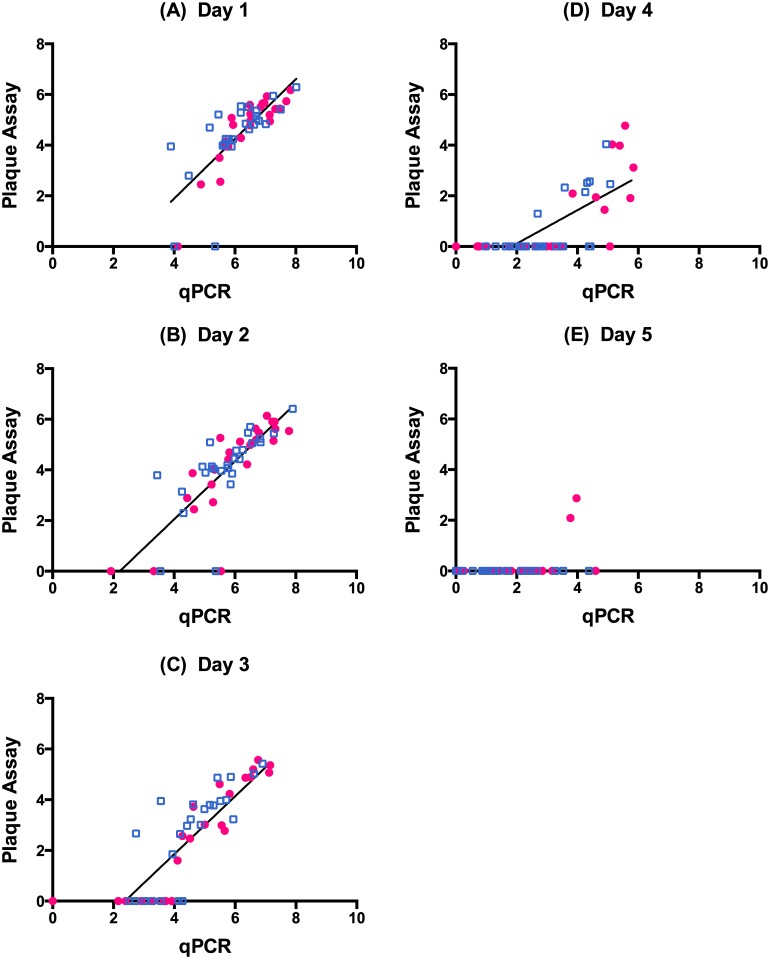
Correlation between viremia by qPCR and plaque assay.Red filled circles–patients who received celgosivir; blue open squares–patients who received placebo; lines–linear regression to all data. Pearson correlation coefficient for all data (A)Day 1 0.79 (95% CI: 0.64 to 0.87); (B) Day 2 0.79 (95% CI: 0.65 to 0.87); (C) Day 3 0.83 (95% CI: 0.72 to 0.90); (D) Day 4 (95% CI: 0.55 to 0.83); (E) Day 5 0.36 (95% CI: 0.08 to 0.58).